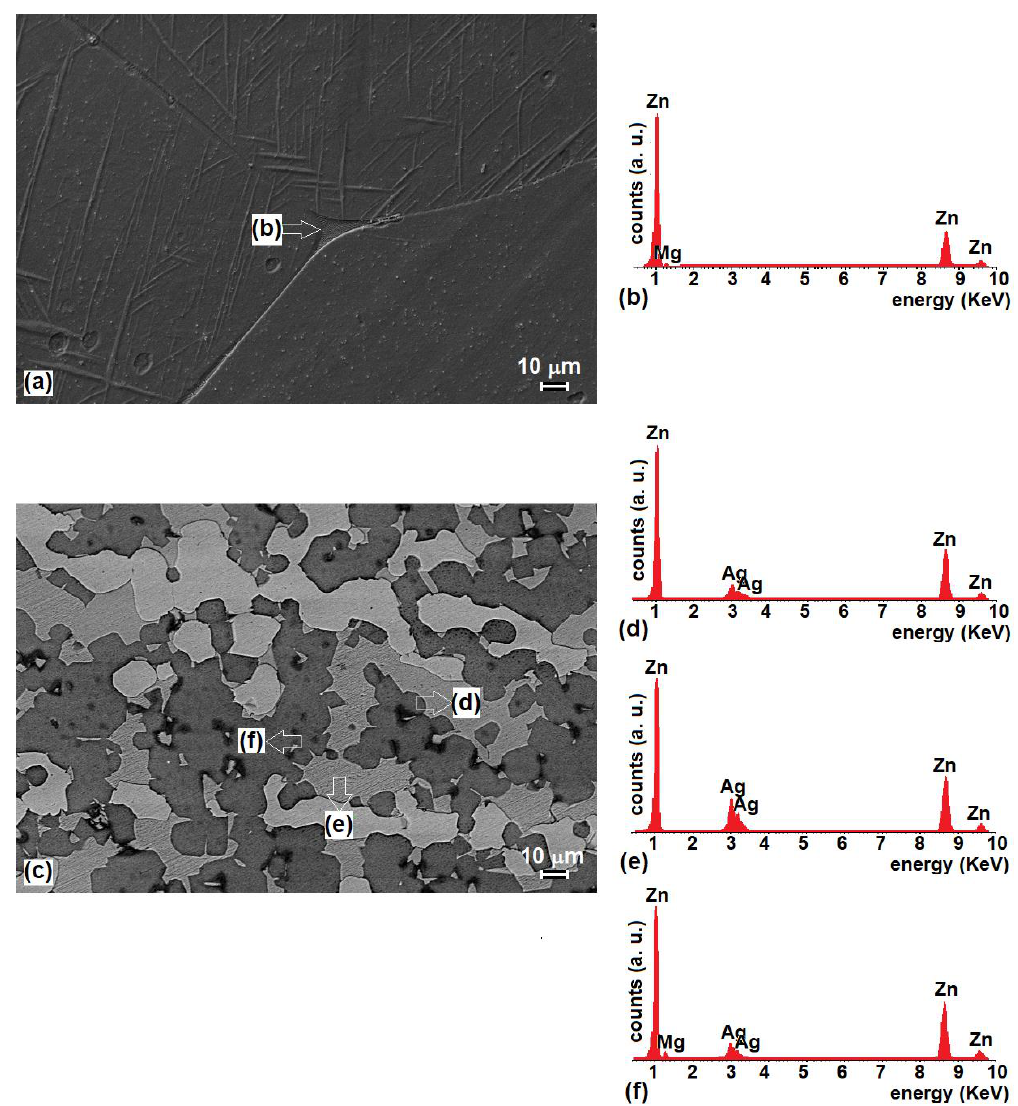
Figure 4. SEM micrograph of ( a ) Zn-1Mg after ST at 370 °C for 5 h; ( b ) EDS spectrum of the Mg 2 Zn 11 microconstituent; ( c ) SEM micrograph of Zn-12.5Ag-1Mg after ST at 370 °C for 5 h: ( d – f ) EDS spectrums corresponding to points D, E, and F.